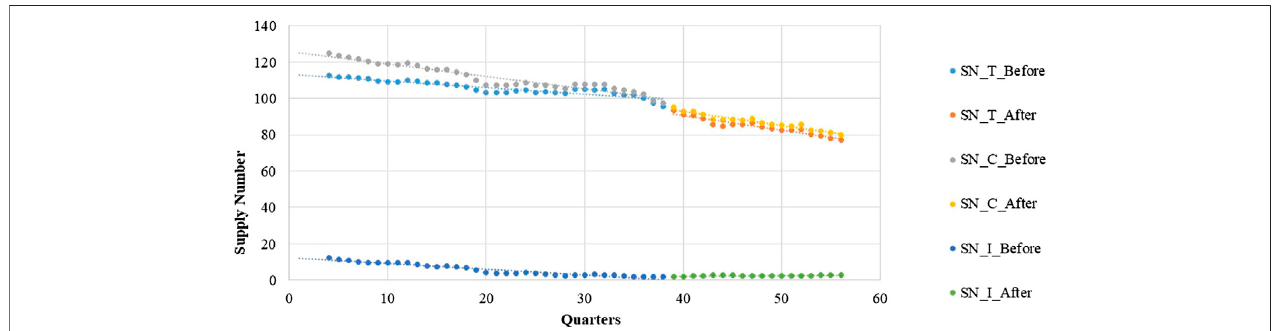
FIGURE 4 | Segmented regression model showing LPCMs ’ supply numbers from 2005 to